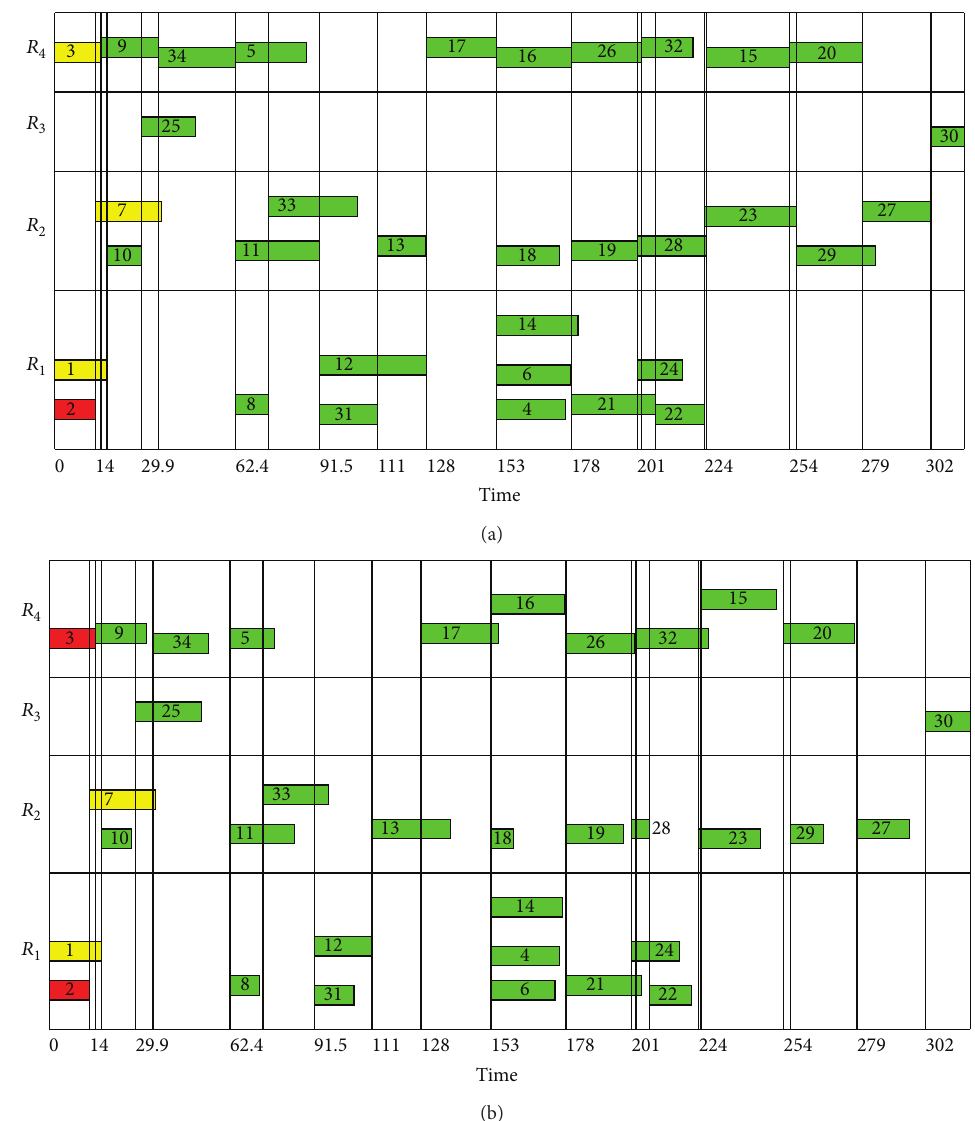
Figure 5: Solution to the subproblem set in the (a) fifth (b) sixth